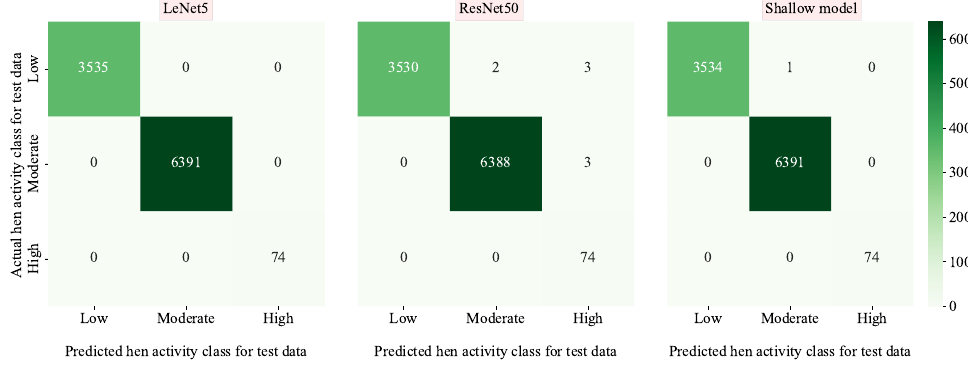
Figure 10. Confusion matrices for the considered recognition models when using the AVM data bundle of the green hen test